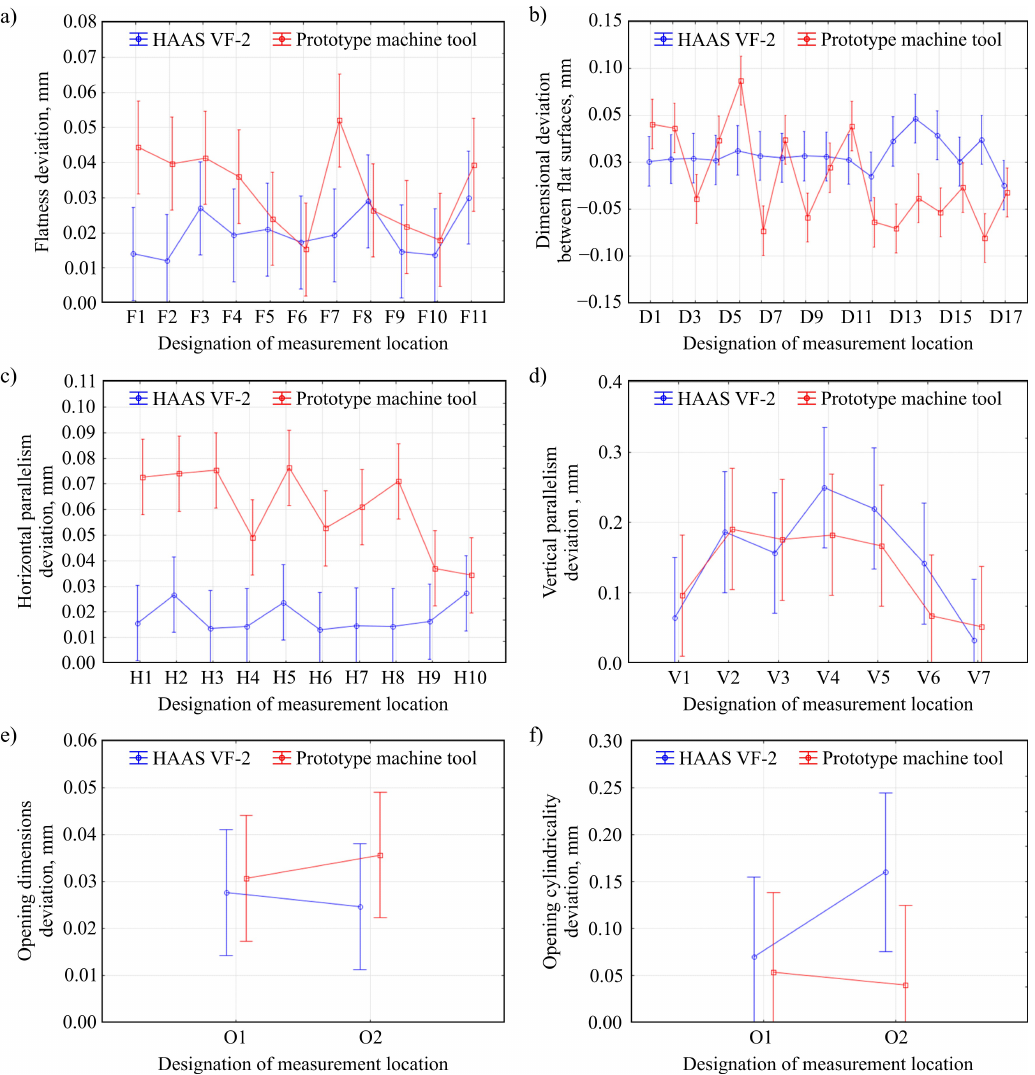
Figure 6. Comparison of the results of geometric measurements of test pieces machined with the use of HAAS VF-2 milling center and prototype machine tool integrating 3D scanning, milling, and shaped grinding: ( a ) flatness deviation; ( b ) dimensional deviation between flat surfaces; ( c ) horizontal parallelism deviation; ( d ) vertical parallelism deviation; ( e ) opening dimensions deviation; ( f ) opening cylindricality deviation (vertical bars present 0.95 confidence intervals, number of measurement repetitions n = 3).